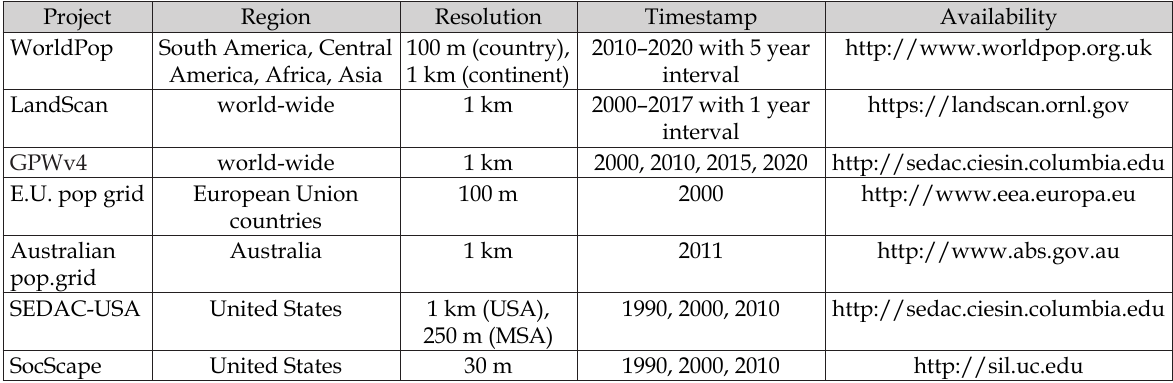
Table 1. Characteristics of broad-scale population